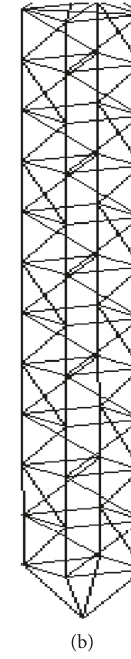
Figure 6: Construction scheme of lifting frame. (a) Original scheme. (b) New scheme.